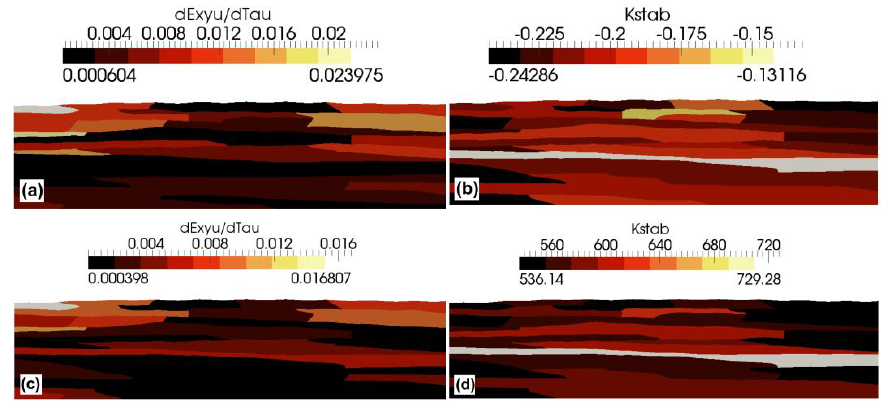
Figure 9. Numerical simulation results were obtained for the CDD process ( a , b ) and IDD process ( c , d ); distribution of the shear strain rate in s − 1 ( a , b ) and the coefficient of the plastic deformation stability ( b , d ).